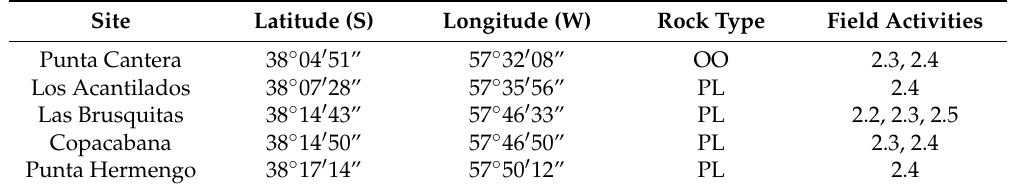
Table 1. Study site coordinates, rock type, and field